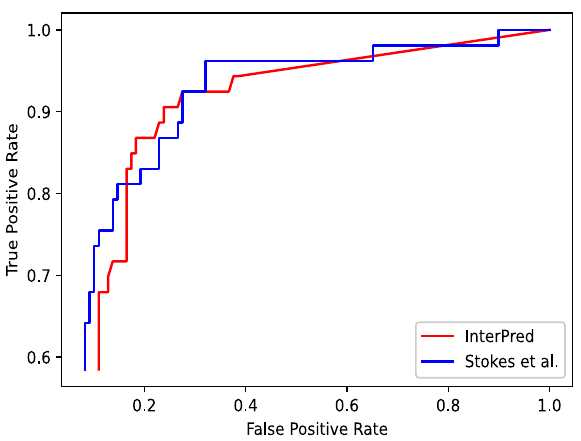
Figure 3. ROC curve for neural network model from Stokes et al. and InterPred. For false positive rates greater than 0.3, the models have nearly identical true positive rate.